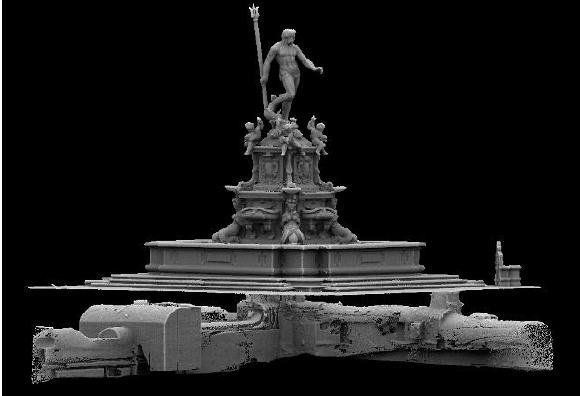
Figure 5. The 3D point cloud of the Fountain of the Neptune (above and underground in the same reference system), obtained by the TOF laser